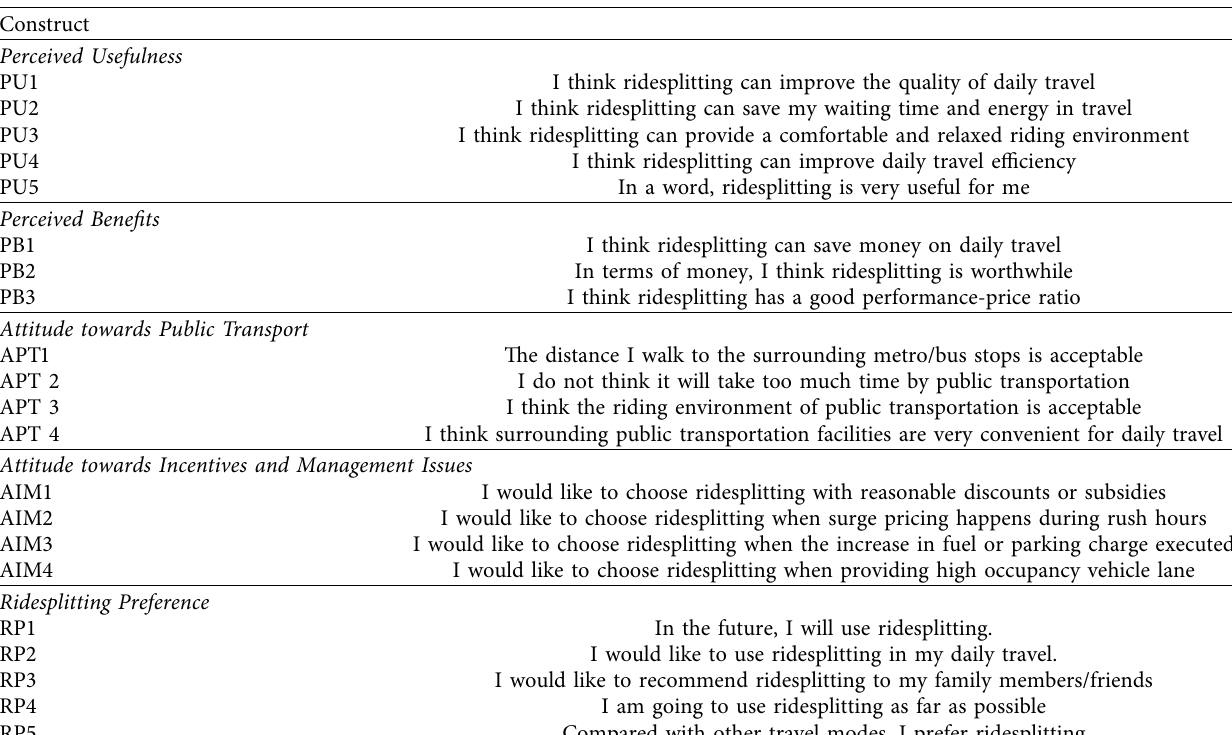
Table 1: Questions in user attitudes investigation section.